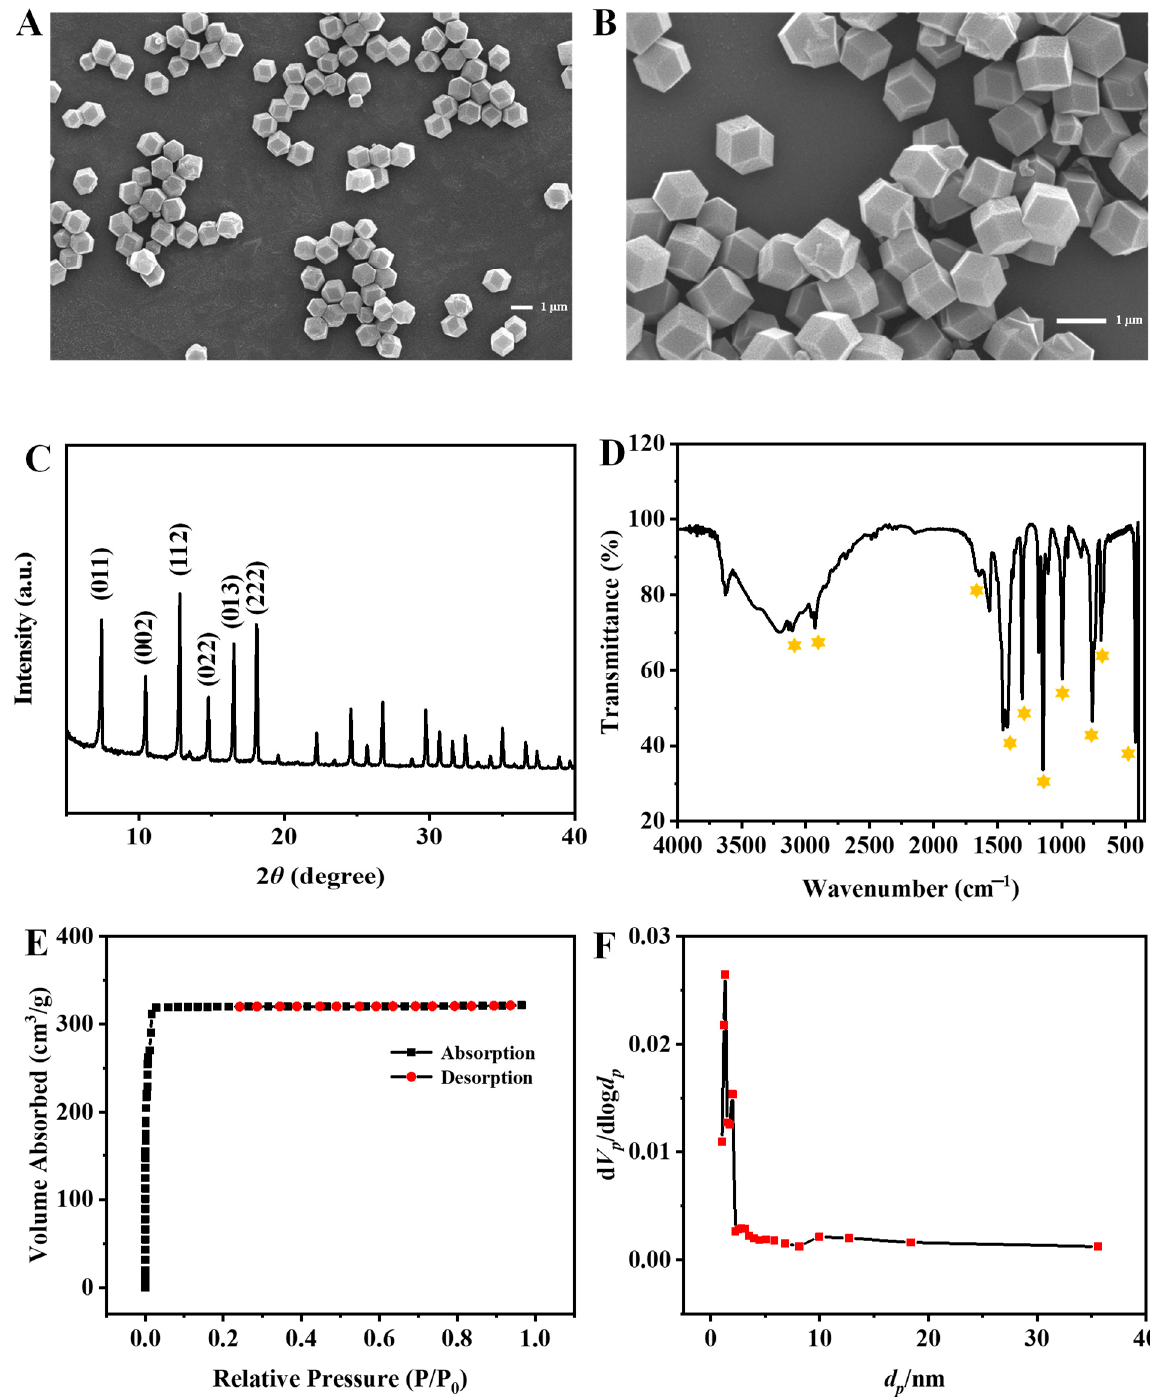
Figure 2. SEM images ( A , B ), XRD spectrum ( C ), FT-IR spectrum ( D ) of ZIF-8, nitrogen adsorption- desorption isotherm ( E ) and pore-size distribution ( F ).